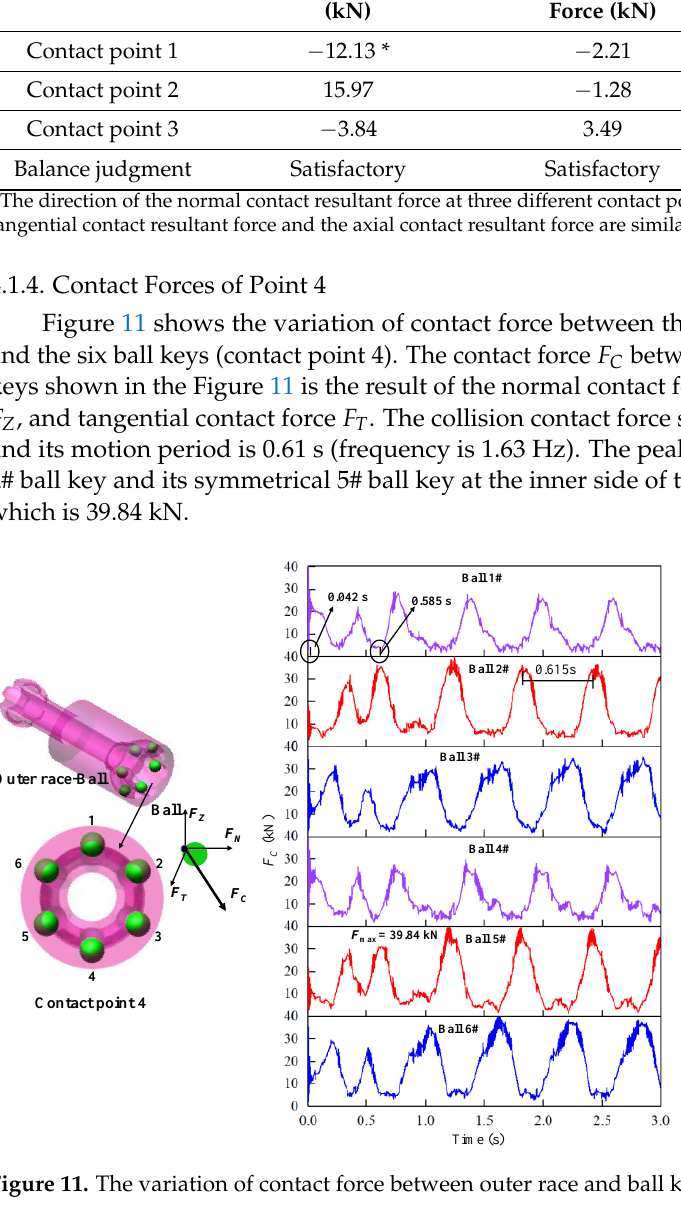
Figure 12. The variation of contact force between inner race and ball keys.